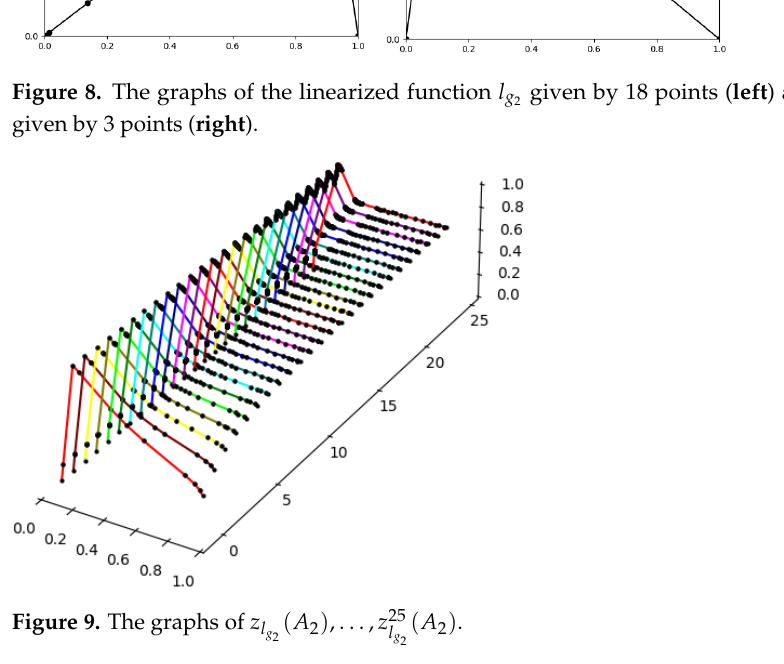
Figure 9. The graphs of z l